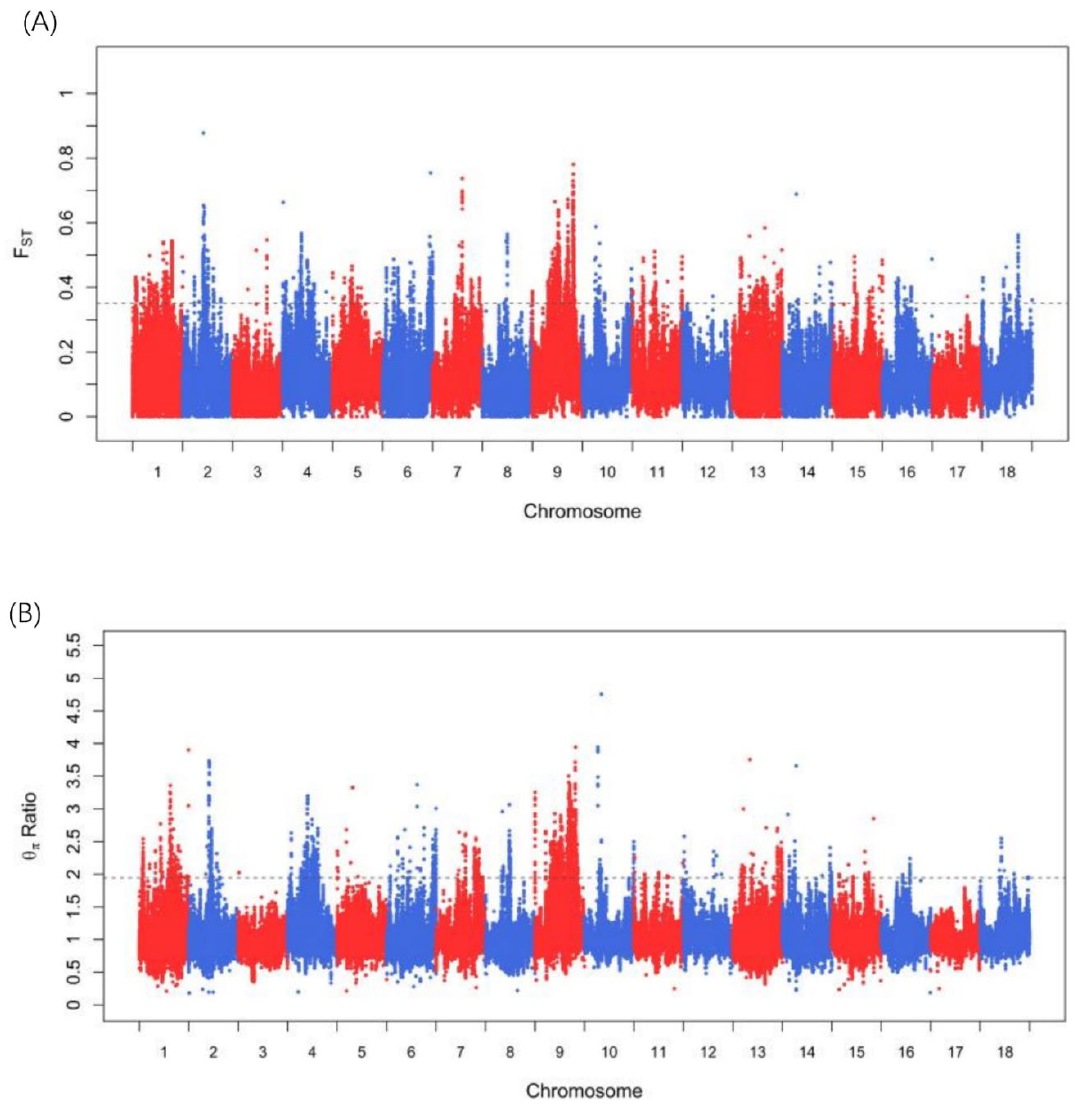
Figure 2. Identification of genomic regions with selection in the Wanbei pig population compared to Asian wild boar, which are calculated in a 100-kb sliding window approach with 10 kb step-size. ( A ) Distribution of FST values among autosomal chromosomes. The grey line represents the 0.01 level. ( B ) Distribution of θπ ratio among autosomal chromosomes. The grey line represents the 0.01 level.